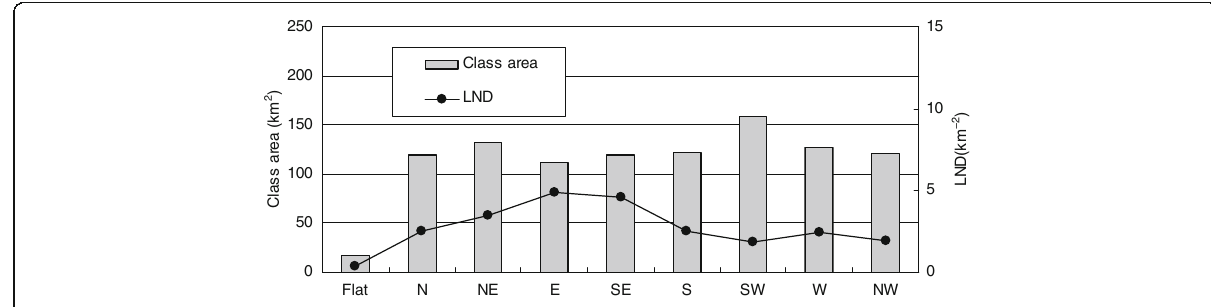
Fig. 12 Same as Fig. 10 but for slope aspects ( horizontal